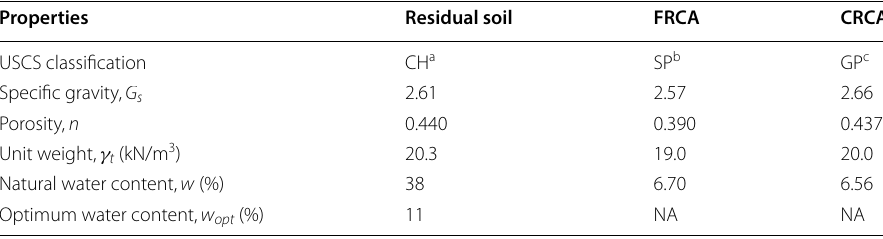
a Highly plastic clay b Poorly graded sand c Poorly graded gravel